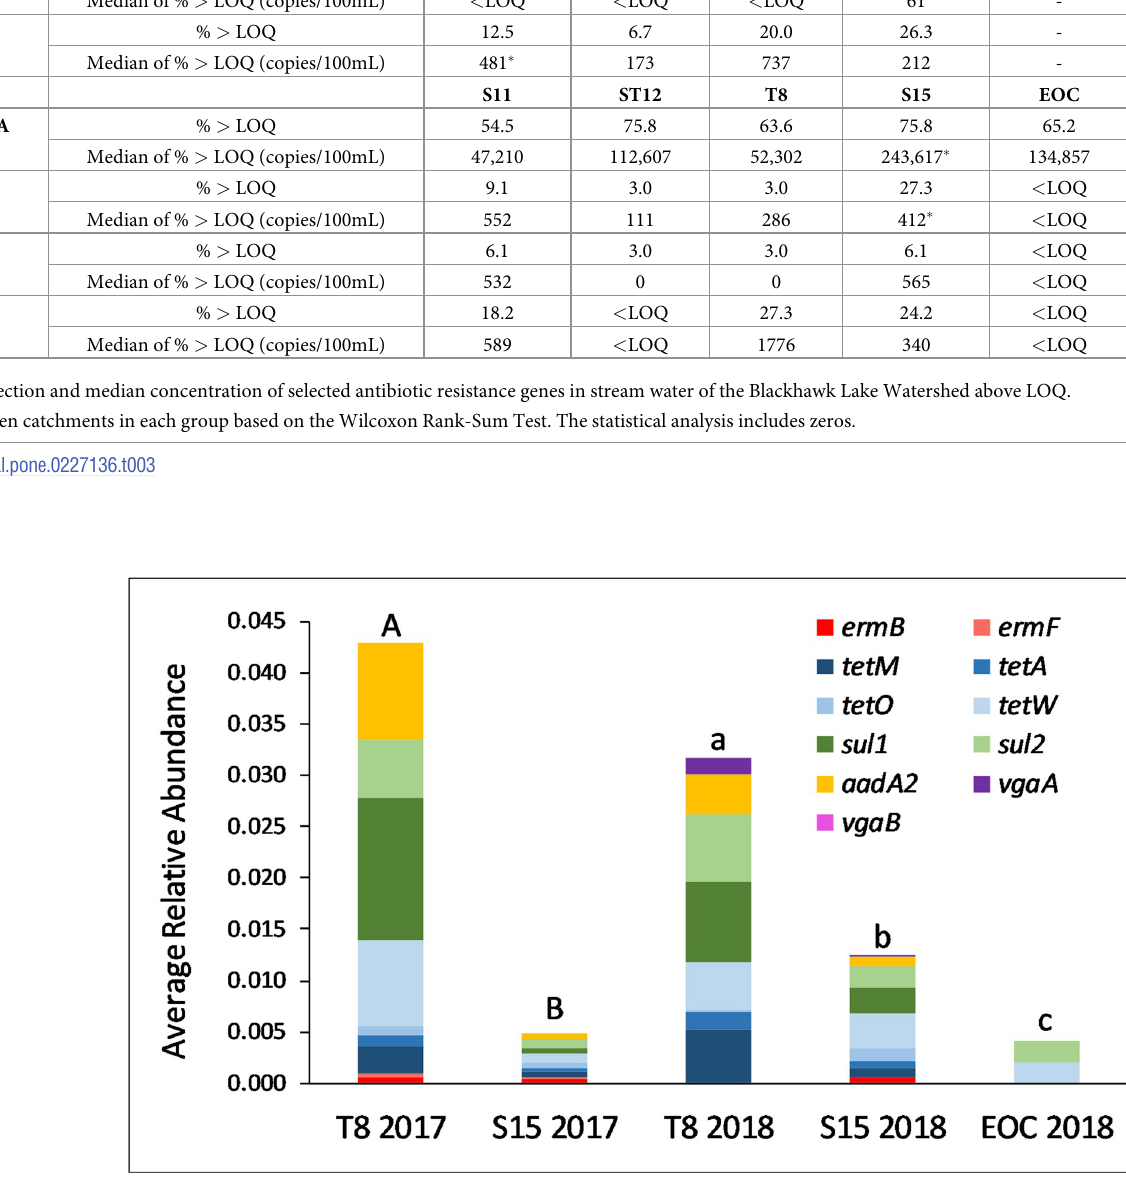
Fig 5. The average relative abundance from each ARG for the mixed land use comparison. The letters above each plot represent total relative abundance significant differences based on the Wilcoxon Rank-Sum Test. Capital letters are associated with 2017 and lower-case letters are associated with 2018. Differing letters mean significant difference between